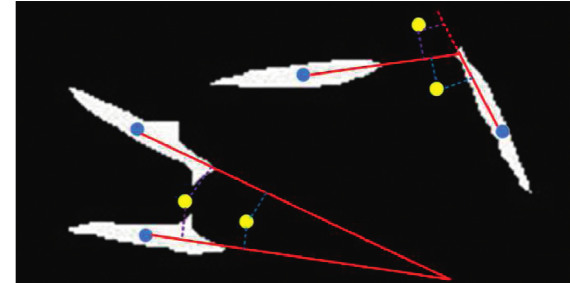
Figure 9: Match verification diagram.